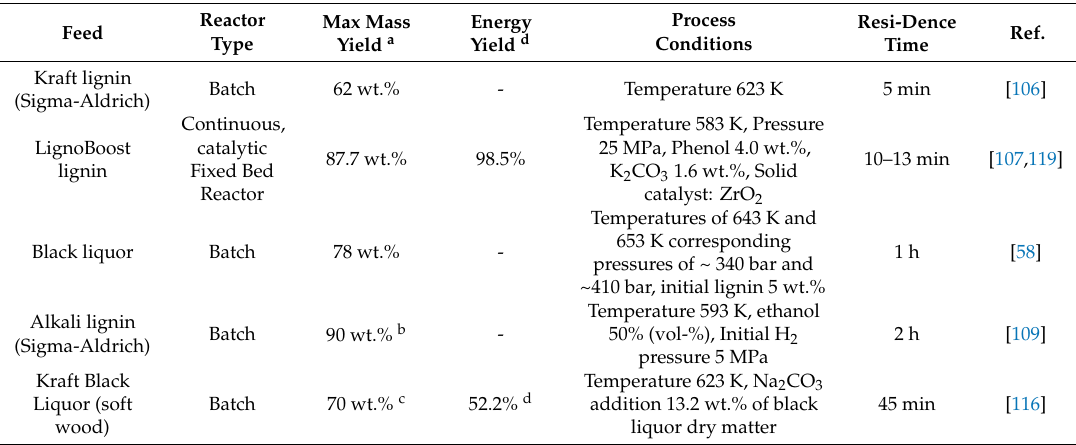
Table 6. The maximum bio-oil yields and the corresponding process